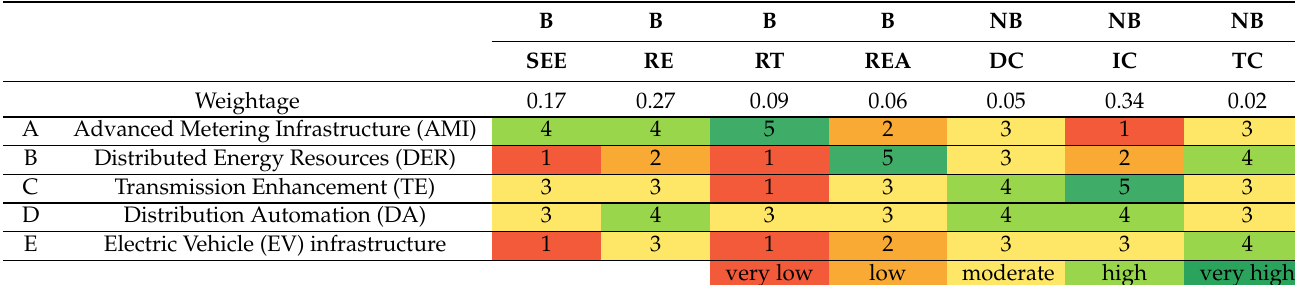
Table 19. The base table. B ≡ Beneficial, NB ≡ Non-Beneficial. SEE ≡ System Efficiency Enhancement, RE ≡ Reliability Enhancement, RT ≡ Reduced Theft, REA ≡ Renewable Energy Adoption, DC ≡ Deployment Challenges, IC ≡ Investment Cost, TC ≡ Technological